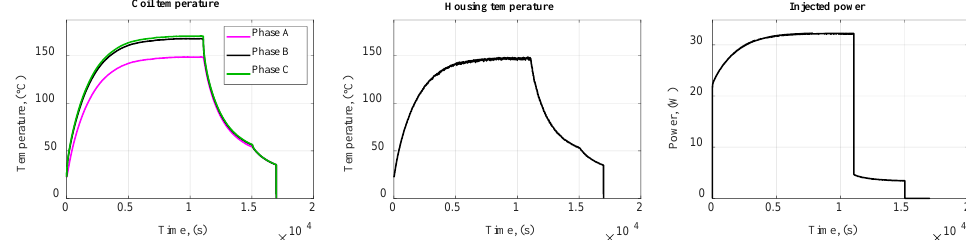
Figure 4. Measured temperatures for the pulse test with the lowest injected current value in con- figuration A.